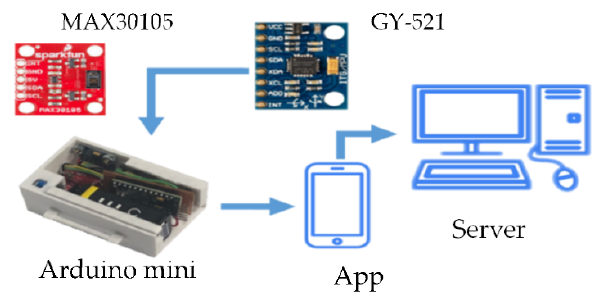
Figure 18. The system hardware and prototype.